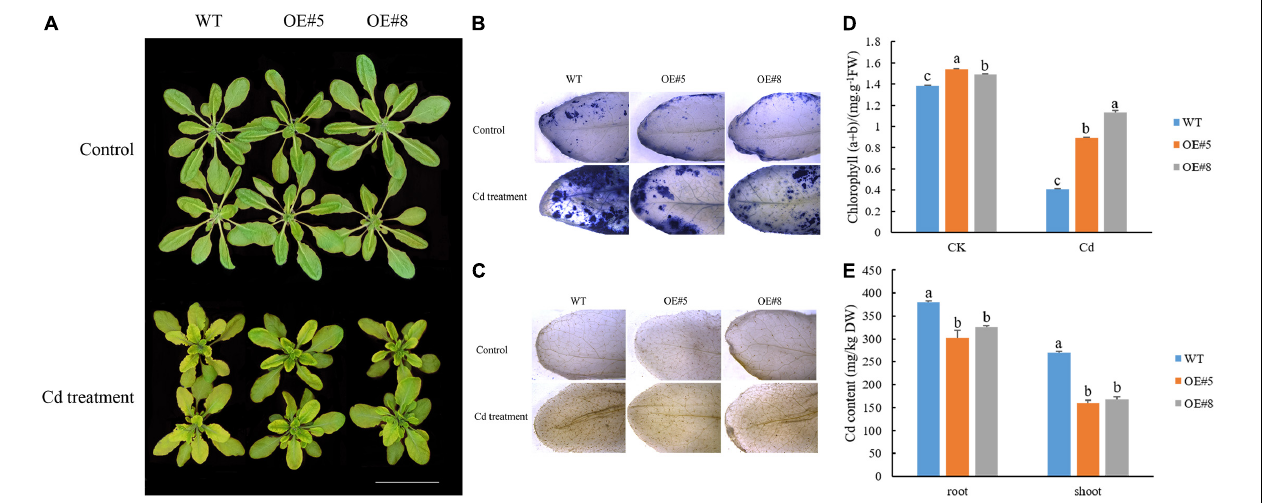
FIGURE 10 | Effects of Cd stress treatments on the growth of SpbZIP60 -overexpressing Arabidopsis plants. (A) Phenotypes of SpbZIP60 -overexpressing transgenic lines and wild-type (WT) plants under normal conditions or in response to the Cd treatment. Bar = 5 cm. (B) NBT staining results. (C) DAB staining results. (D) Chlorophyll contents of the WT and transgenic lines before and after the Cd treatment. (E) Cd contents of the WT and transgenic lines. Bars represent the mean ± standard deviation (SD) of at least three independent biological replicates. Significant differences according to a one-way analysis of variance are denoted as follows: p < 0.05 (Duncan’s